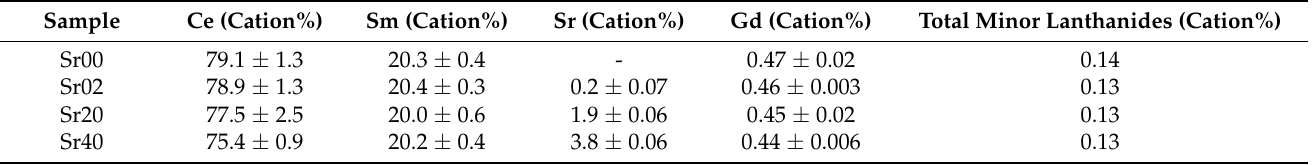
Table 1. Concentrations of the main cations and Gd, as determined by ICP-MS for selected samples of Ce 0.8 − x Sm 0.2 Sr x O 2 − δ .